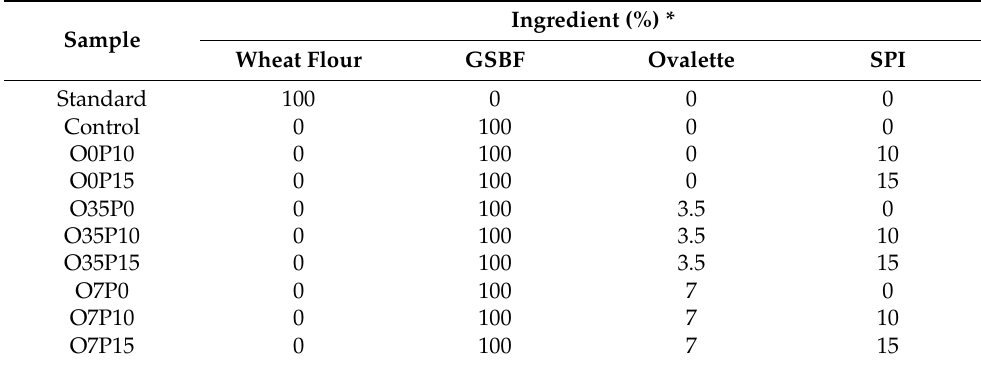
Table 1. The cake formulations under